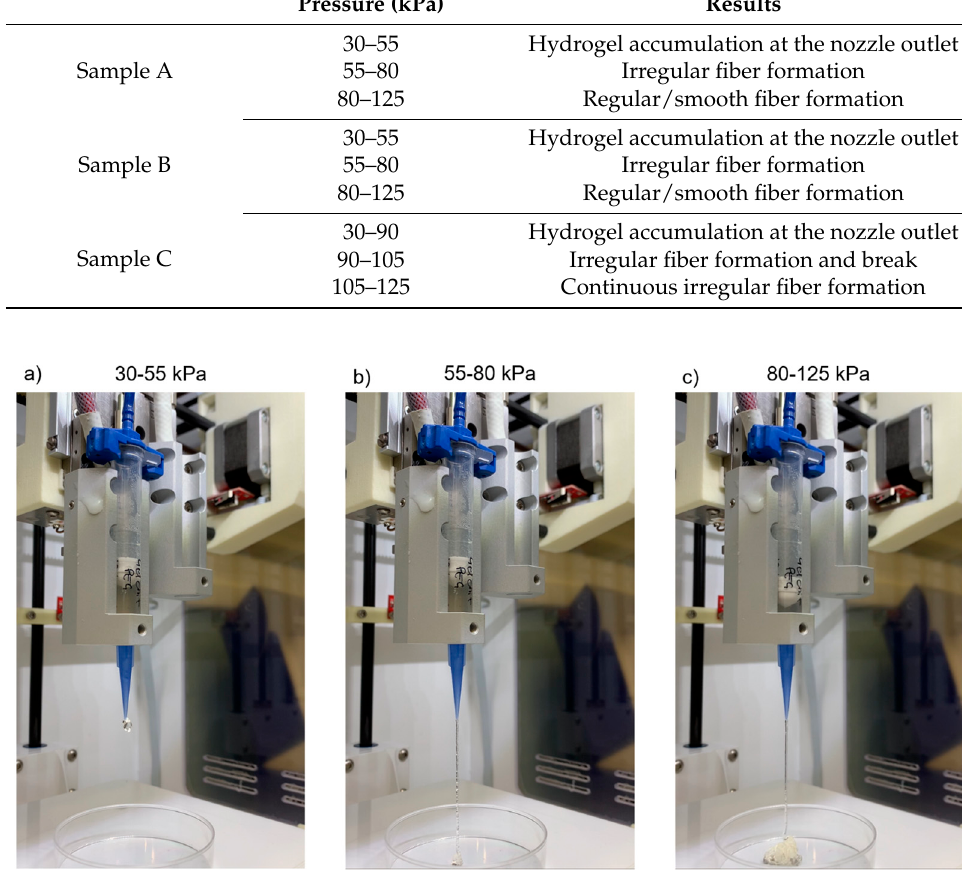
Figure 2. Results of the droplet/fiber formation test for Sample A. ( a ) In the pressure range of 30–55 kPa, hydrogel accumulation occurred at the nozzle outlet; ( b ) at 55–80 kPa, the formation of irregular fibers was observed; ( c ) at 80–125 kPa, regular/smooth fibers were formed.